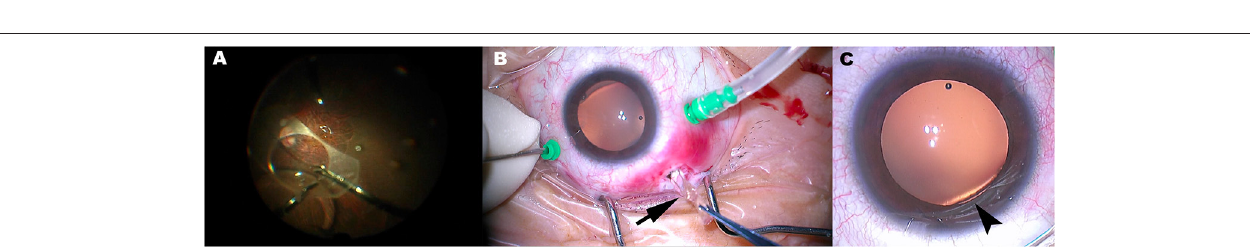
FIGURE 1 | Dislocation of the Ejinn phakic refractory lens (EPRL). (A) Slit-lamp examination shows subluxation of the EPRL, which was observed when the patient visited our center due to complaining of suddenly blurred vision of right eye at 26 months post-operatively. (B) Luxation into the vitreous cavity of the EPRL revealed by fundus photography. (C) Slit-lamp examination shows the position of crystalline lens after the luxation into the vitreous cavity of the EPRL.